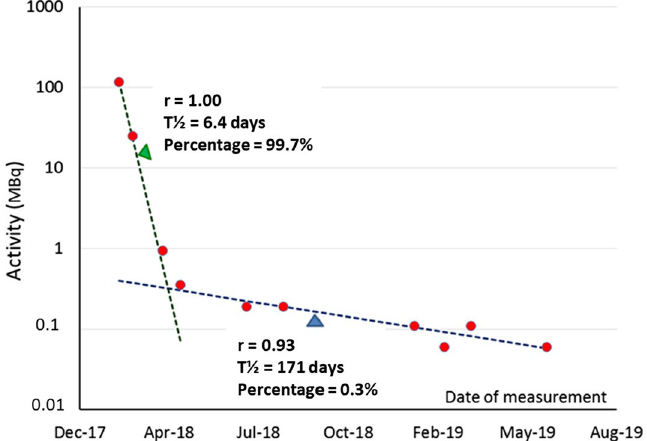
Fig. 1 Plots of a bi‑exponential decay with fitting curves and calculated parameters: half‑life, percentage of contaminants, correlation coefficient ( r )